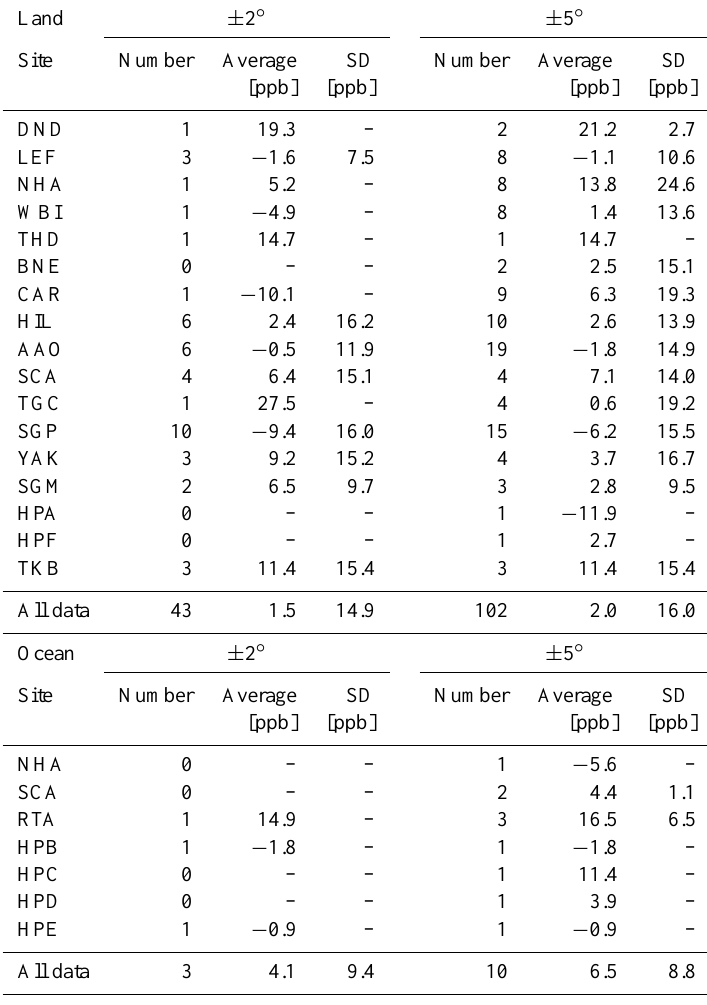
Table 5. Differences between GOSAT XCH 4 and aircraft-based XCH 4 at each site. The GOSAT data were retrieved over land and ocean regions within ± 2 ◦ and ± 5 ◦ latitude–longitude boxes centered at each aircraft observation site.